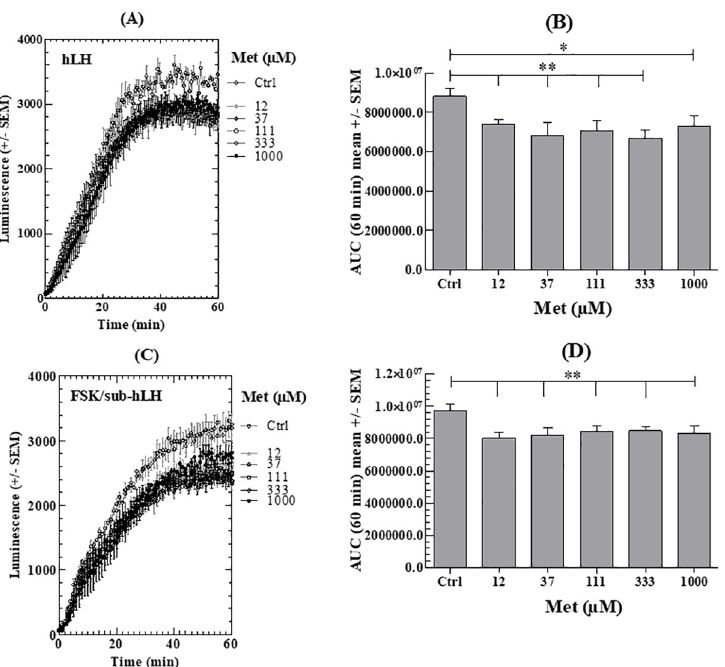
Fig 5. Effect of MET on cAMP response of MLTC-1 cells to hLH or FSK/sub-hLH. (A), (C) Real-time recording of luminescence under stimulation of MLTC-1 cells by hLH or FSK/sub-hLH in the presence of 0 to 1000 μ M MET. (B), (D) Dose-dependent effects of MET determined on hLH and FSK/sub-hLH responses respectively, by the Area Under Curve (AUC) of individual kinetics in Fig 5A and 5C. Data represent mean ± SEM of 3 independent experiments (n = 3). Results were analyzed by one-way ANOVA, followed by the Dunnett’s test posttest). � : significant difference ( � P < 0.05; �� P <